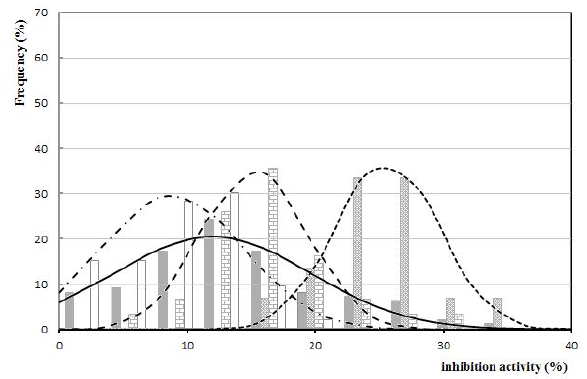
Figure 11: Distribution of inhibitory activity to urokinase in oat extracts expressed as % of inhibitory activity (solid column and solid line – complete set, r 2 = 0.897, bracket column and dash line – minor red subset, r 2 = 0.957, dots column and dash-and-dot line – major green subset, r 2 = 0.973, empty column and dots line – major blue subset, r 2 = 0.915, the mentioned colors correspond to the colors in Fig. 7 and Fig. 8).